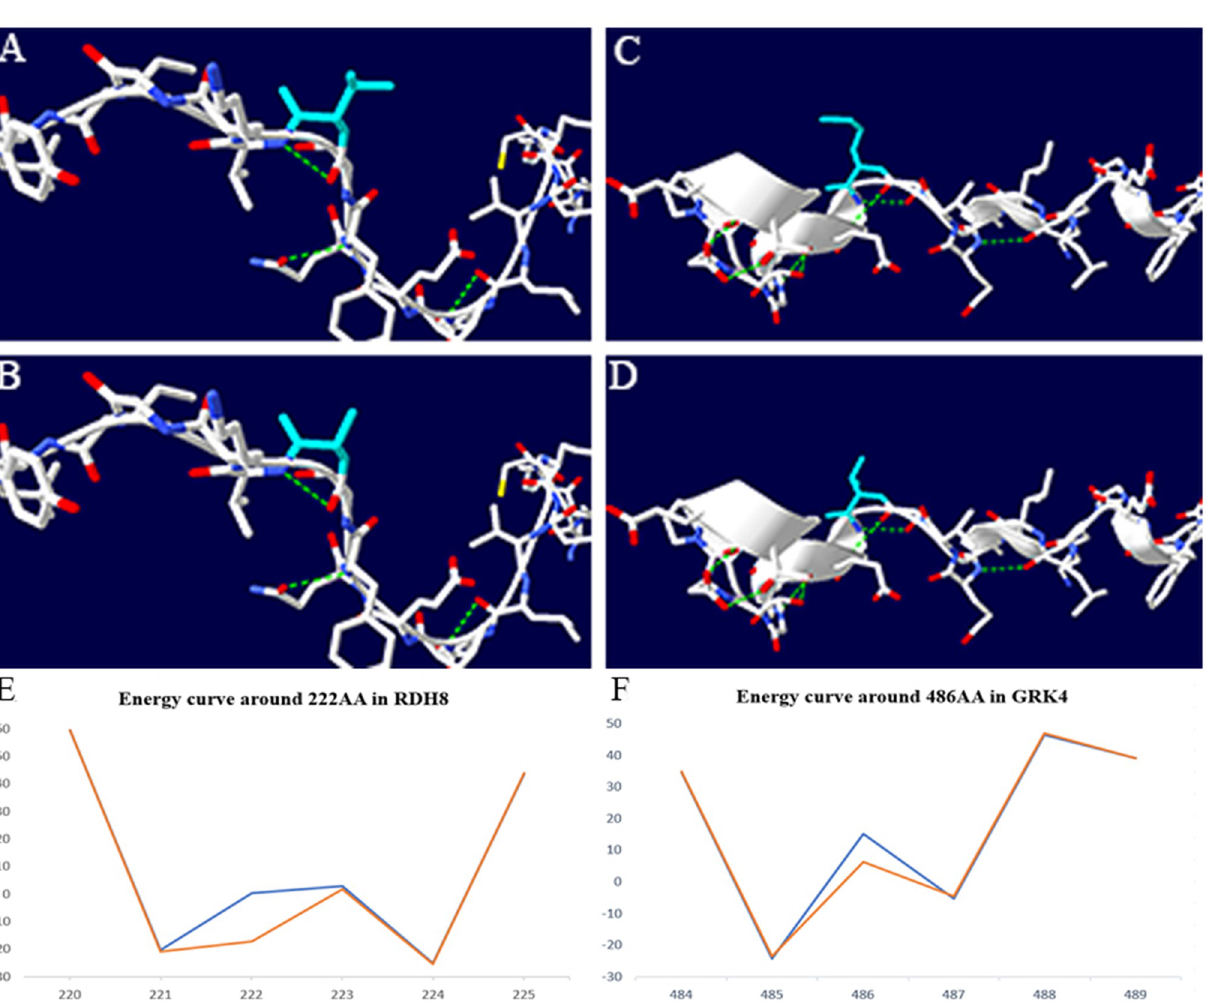
Fig 2. Schematic diagram of 3D protein structure and force field curves. A, B light blue represents amino acid 486 Val / Ala before and after mutation in GRK4 ; C, D light blue represents amino acid 222 Met / Thr before and after mutation in RDH8 . The green dotted line represents hydrogen bonding. E. The blue line represents RDH8 p . 222M . The red line represents RDH8 p . 222T ; F. The blue line represents GRK4 p . 486V . The red line represents GRK4 p . 486A